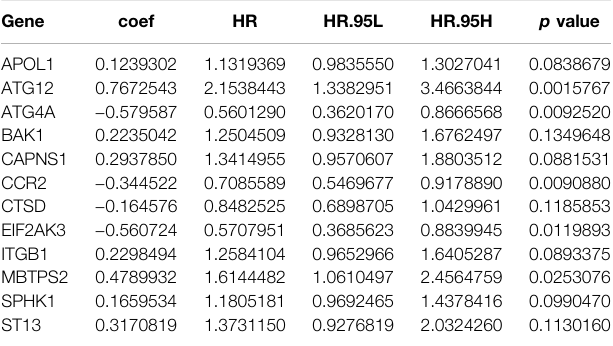
TABLE 2 | Twelve autophagy-related genes are independent prognostic indicators using multivariate Cox regression analysis. Gene